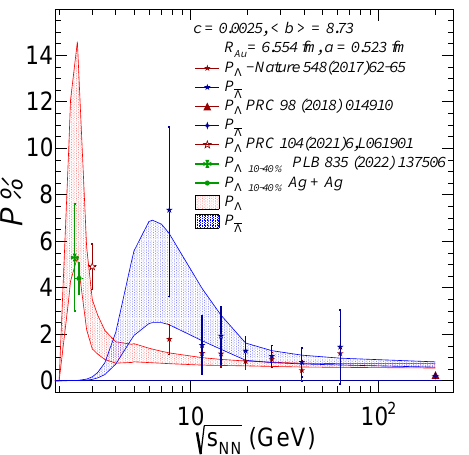
Figure 6. The red and blue shaded regions represent the global polarization P Λ and P Λ as a function of the collision energy for the centrality range 20–50% obtained from the core-corona model. Data from STAR-BES Au+Au [14–16] and HADES Au+Au and Ag+Ag measurements